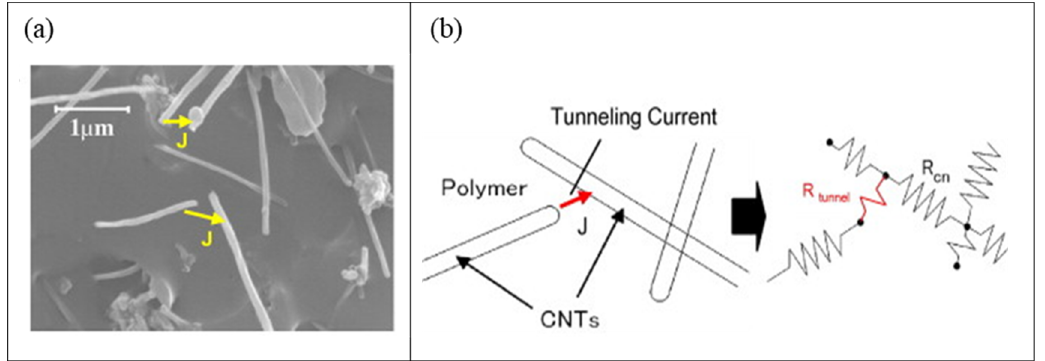
Figure 2. ( a ) SEM image of possible tunneling effect between CNTs in nanocomposites; ( b ) tunnel resistance modeling of resistance network [35] (Copyright 2008, Elsevier Ltd.).